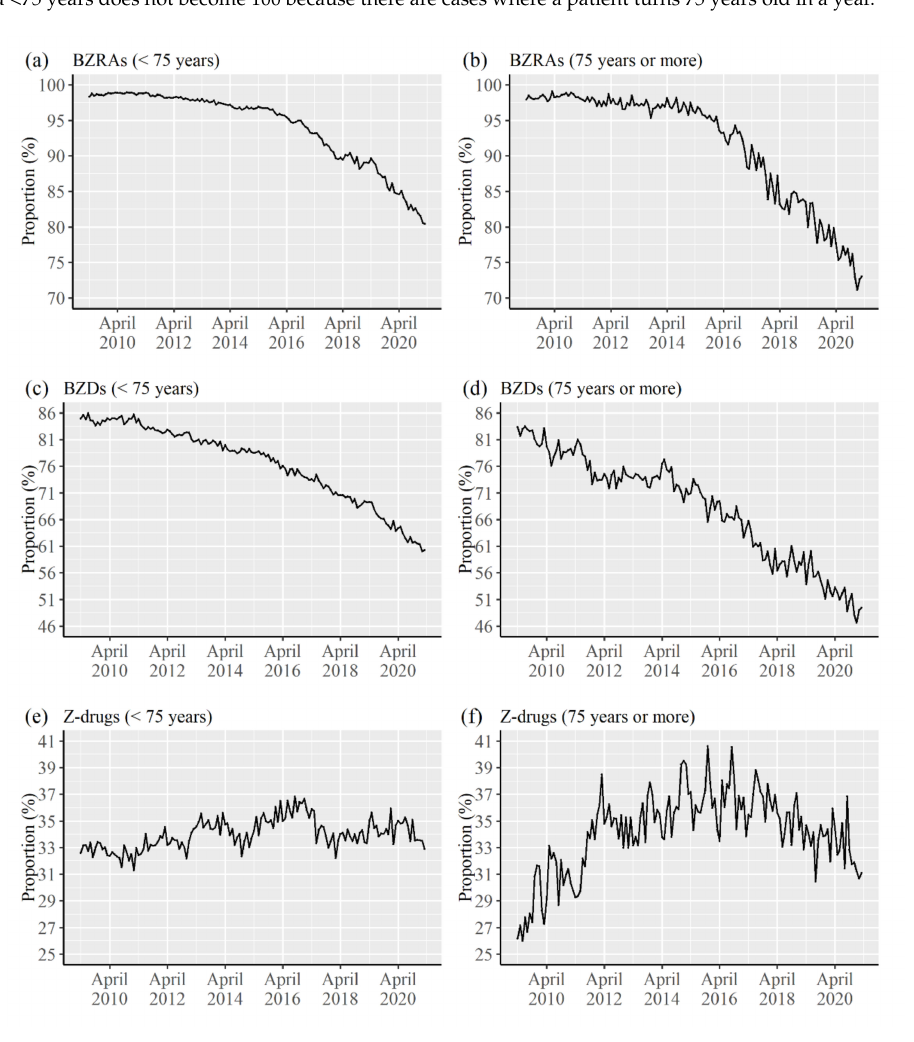
Figure 1. Trends of the proportion of patients prescribed drugs among those prescribed hypnotics or anxiolytics in a month by age group and type of drug. ( a ) Proportion for BZRAs in patients aged <75 years. ( b ) Proportion for BZRAs among patients aged ≥ 75 years. ( c ) Proportion for BZDs among patients aged <75 years. ( d ) Proportion for BZDs among patients aged ≥ 75 years. ( e ) Proportion for Z-drugs among patients aged <75 years. ( f ) Proportion for BZDs among patients aged ≥ 75